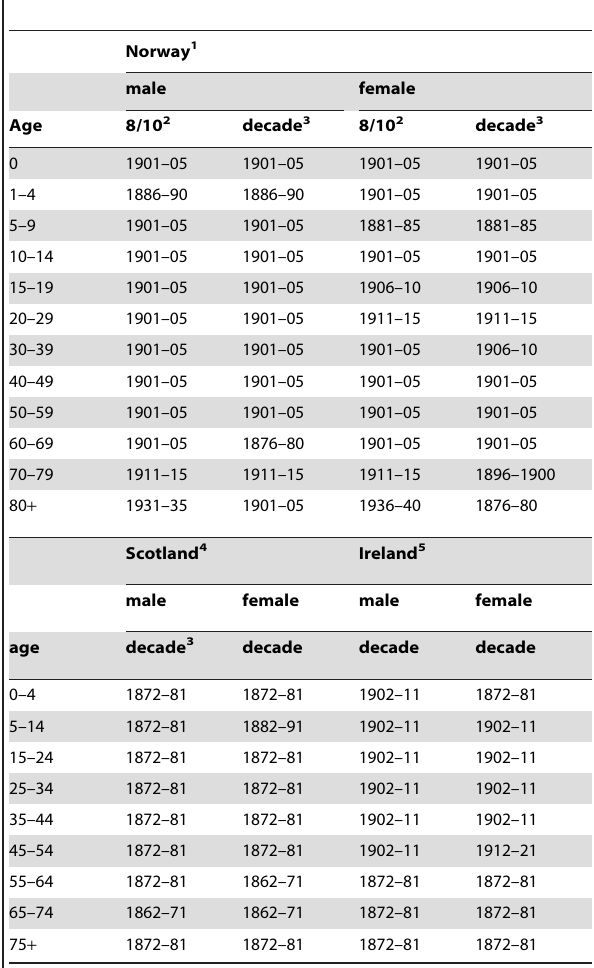
Table 3. Dates of onset of decline of tuberculosis mortality in Norway, Scotland and